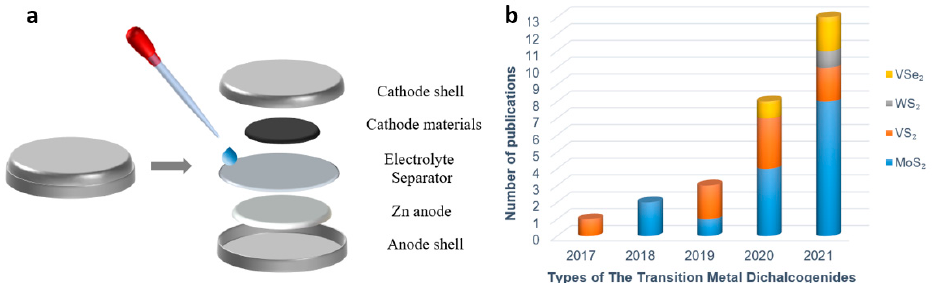
Figure 1. ( a ) Disassembly diagram of coin ‐ type ZIBs; ( b ) The trend of publications on TMDs as ZIBs cathode materials. cathode